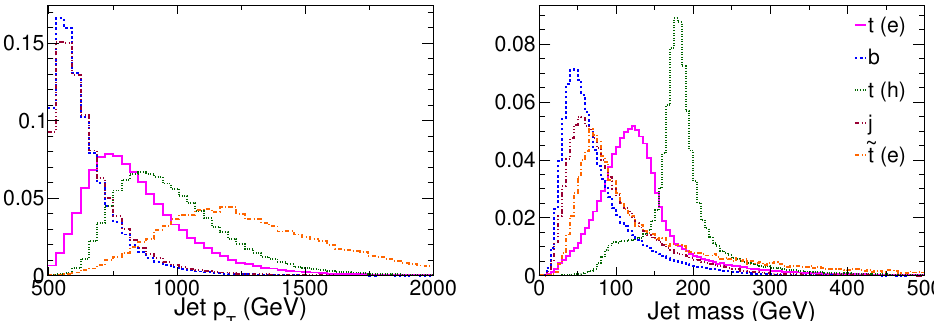
Figure 1 . Distribution of p T (left), and mass (right) of the ungroomed jet for all the event samples.